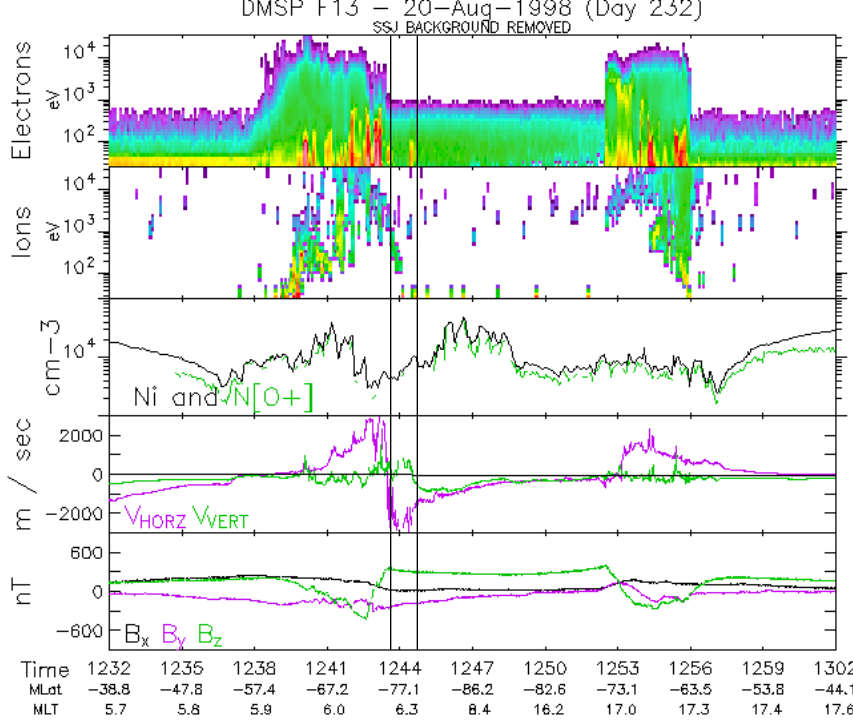
Fig. 11. Southern Hemisphere DMSP F13 data for the interval 12:32–13:02UT. Flow channel FC 2 (panel 4) is marked by vertical guidelines. Event category is SH-dawn/ B y < 0 (dark).